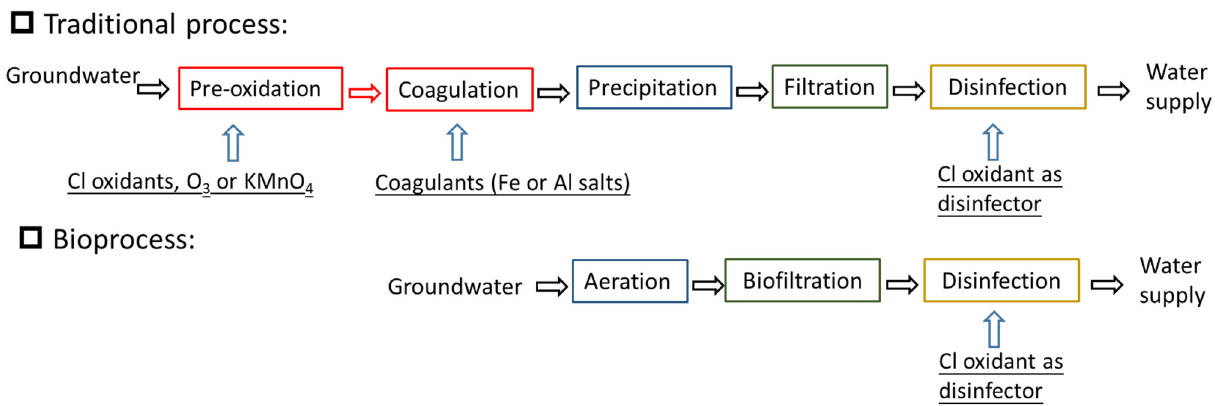
Figure 3. Processes designed for removal of Mn 2+ from groundwater.